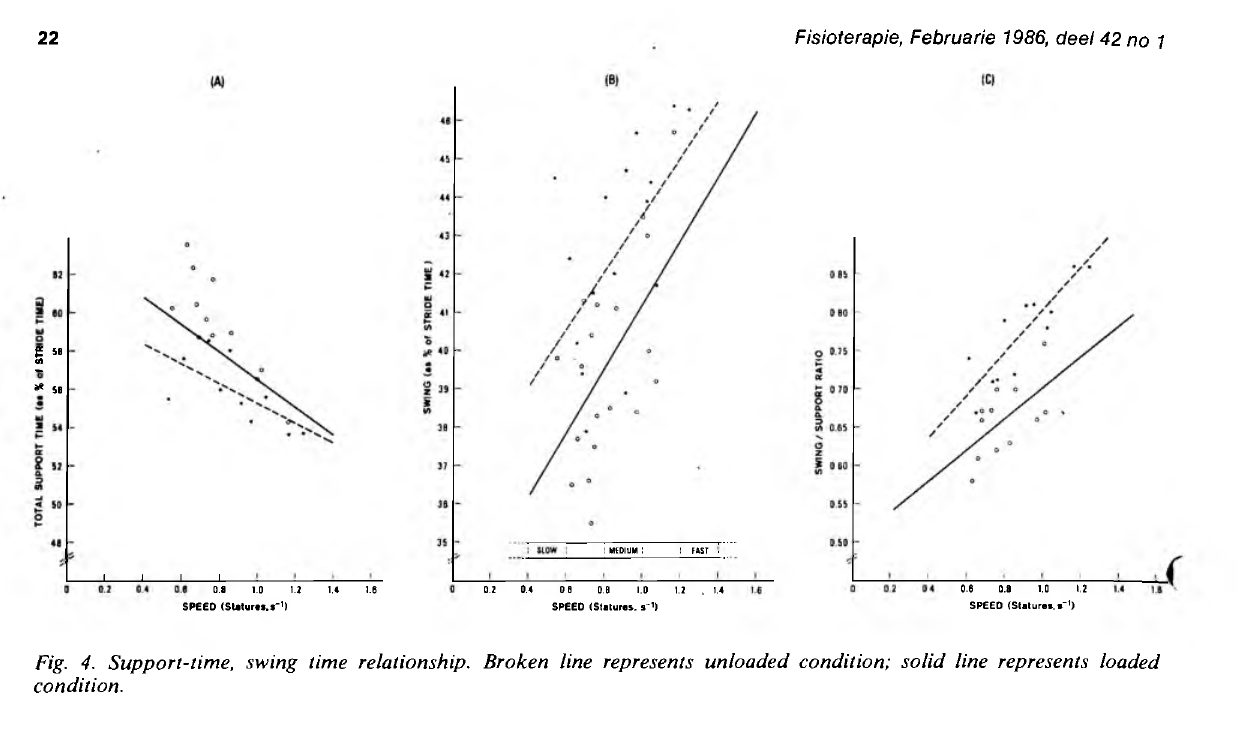
Fig. 4. Support-time, swing time relationship. Broken line represents unloaded condition; solid line represents loaded condition.